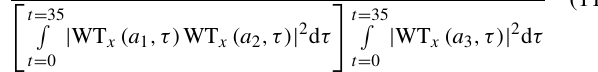
Figure 2 exhibits a simple illustration of the wavelet-based bicoherence of a narrow-banded Gaussian wave train (Test 1) recorded at x = 4 m from the wave maker. The shading in- dicates the strength of non-linear coupling, with dark red ( b 2 (f 1 , f 2 ) = 1) being totally coupled and dark blue ( b 2 (f 1 , f 2 ) = 0) completely uncoupled. The degree of phase cou- pling is represented by the colour bar indicating the sum in- teractions between two frequencies. In this manner, a visual- isation of the non-linear activity across the wave train prop- agation is feasible, detecting the frequency sections of the signal that contribute the most to the non-linear activity. The two frequencies f 1 and f 2 are normalised by the peak fre- quency f p . Red ( b 2 (f p , f p ) ) and yellow peaks represent the phase coupling of the primary frequency component with its harmonic. In general, a non-null bicoherence b 2 (f 1 , f 2 ) > 0 means that the f 3 = f 1 + f 2 component gains energy from the f 1 and f 2